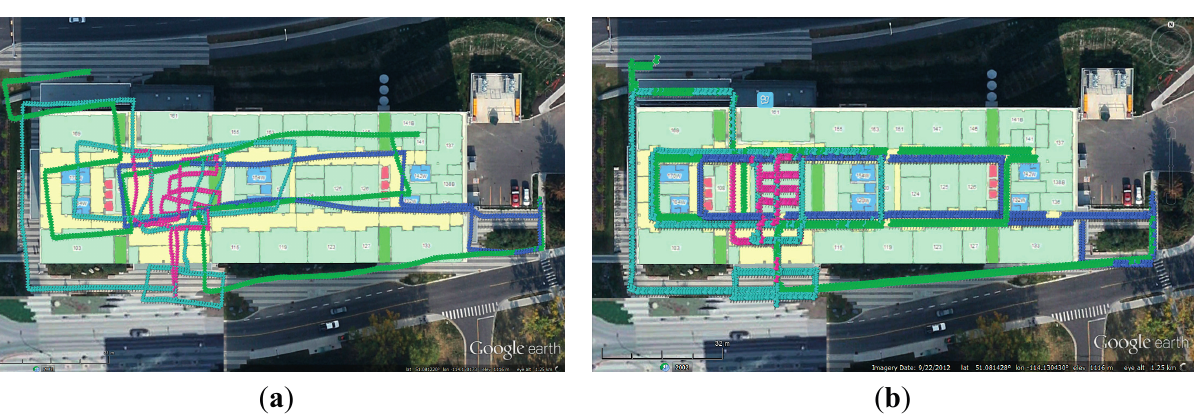
Figure 7. The DB built through proposed method ( a ), and the reference DB built by using the conventional floor plan aided training approach ( b ).